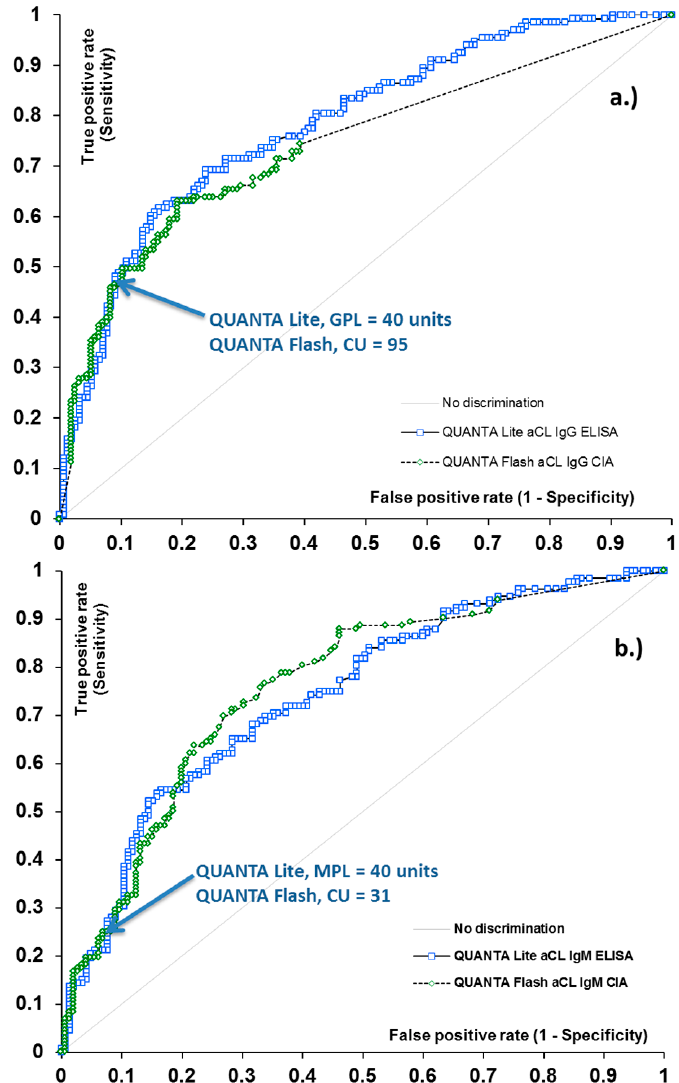
Figure 1. Receiver operating characteristic (ROC) analysis of aCL IgG ( a ) and IgM ( b ) methods for antiphospholipid syndrome (APS)-related clinical symptoms. Arrows indicate the clinically relevant threshold between low and medium titer for aCL